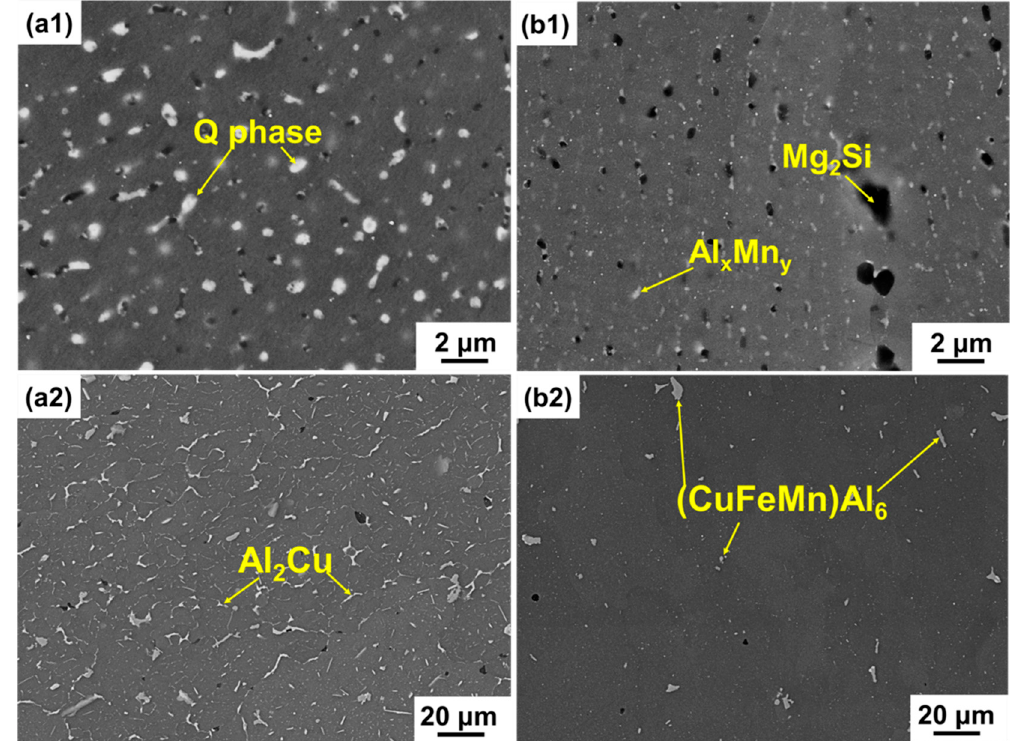
Figure 4. Typical morphologies of the alloys in BSE mode: ( a1 ) The as-SLM alloy; ( b1 ) SLM-T6 alloy; ( a2 ) AA2024-O alloy; ( b2 ) AA2024-T6 alloy.